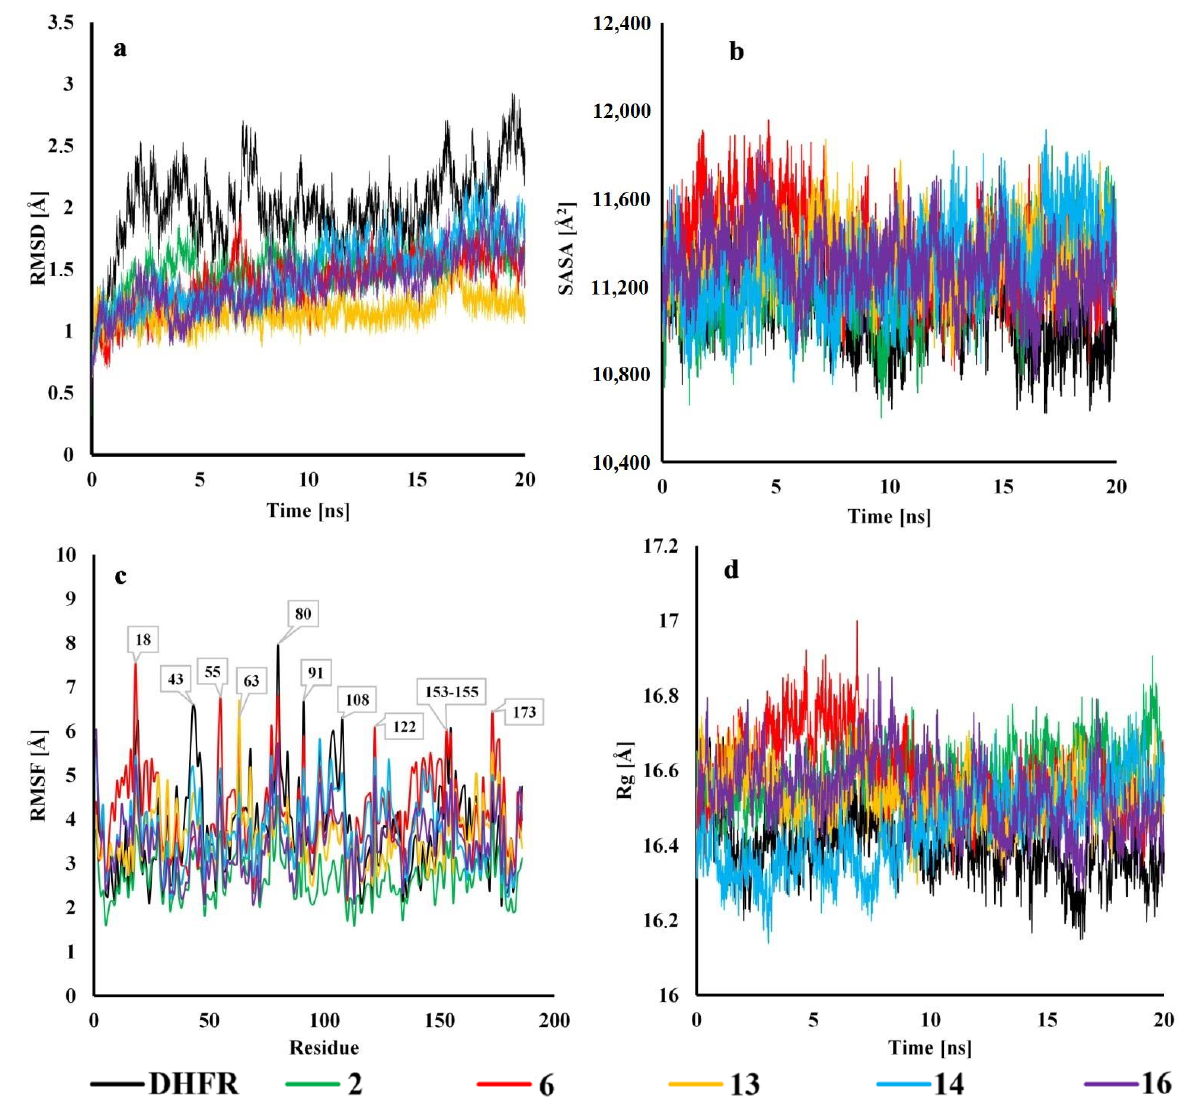
Figure 8. Analysis of RMSD, SASA, RMSF, and Rg of unliganded enzyme (DHFR) and five TMP derivative complexes with protein during 20 ns MD simulations. ( a ) Root-mean-square deviation (RMSD) for Cα atoms. ( b ) Solvent accessible surface area (SASA). ( c ) Root Mean Square Fluctuation (RMSF) values for each residue averaged over the entire simulation. ( d ) Radius of gyration (Rg).